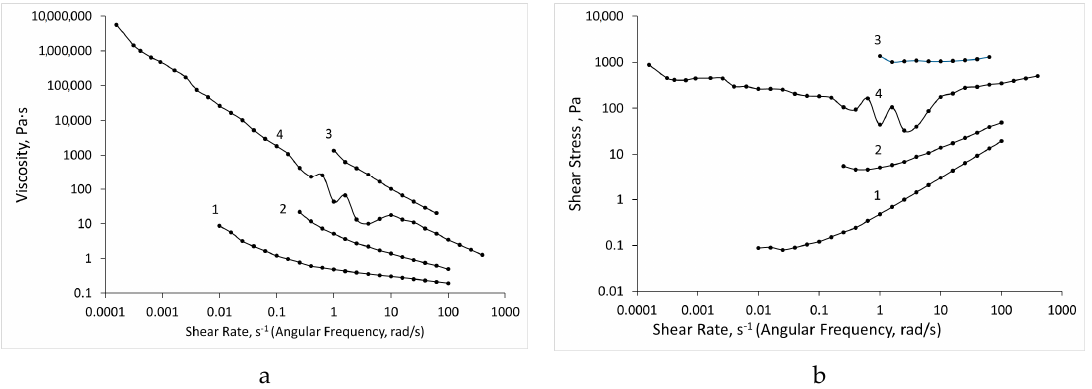
Figure 5. Dependence of viscosity ( a ) and shear stress ( b ) on the shear rate (angular frequency) of the ALG hydrogel: 1—shear test in the Down SR mode, 2—dynamic test in the Down F mode, 3—shear test in the Top SR mode, 4—dynamic test in the Top F mode.